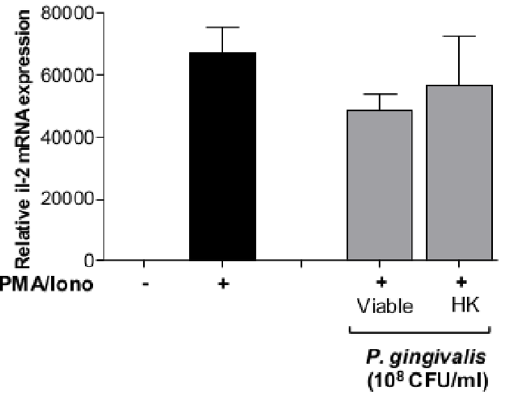
Figure 6. RT-qPCR analysis of il-2 gene-expression in response to P. gingivalis . Jurkat T-cells (10 6 cells/ml) were pre-treated with 10 8 CFU/ml viable- or heat-killed (HK) P. gingivalis (MOI:100) for 1 h followed by stimulation with 50 ng/ml PMA and 1 m g/ml Calcium ionophore for 24 h. Il-2 mRNA levels were not affected by viable or heat-killed P. gingivalis . ***-p , 0.001 (Statistical significance between different treatments and the positive control PMA/Iono, Student’s t